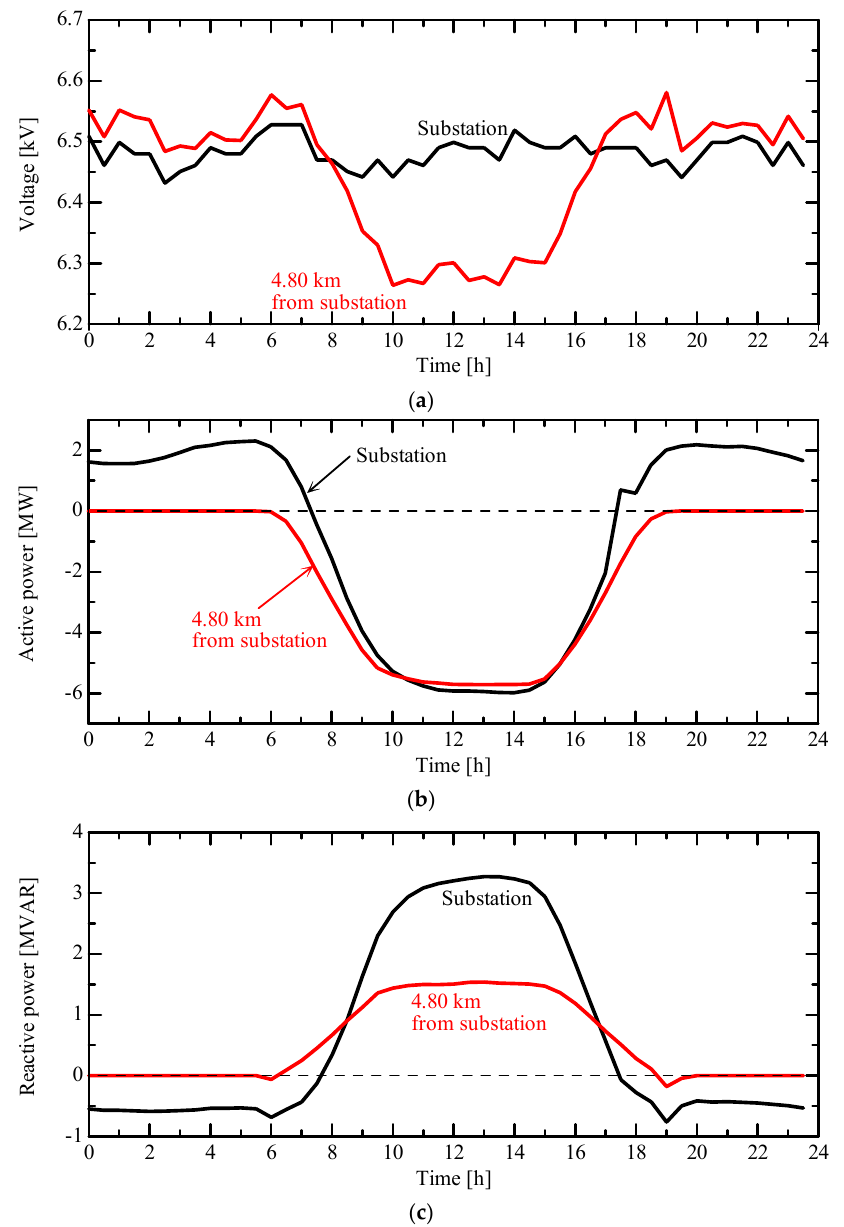
Figure 3. Measured voltage, active power, and reactive power in MV feeder B: ( a ) Voltage; ( b ) Active power; ( c ) Reactive power.